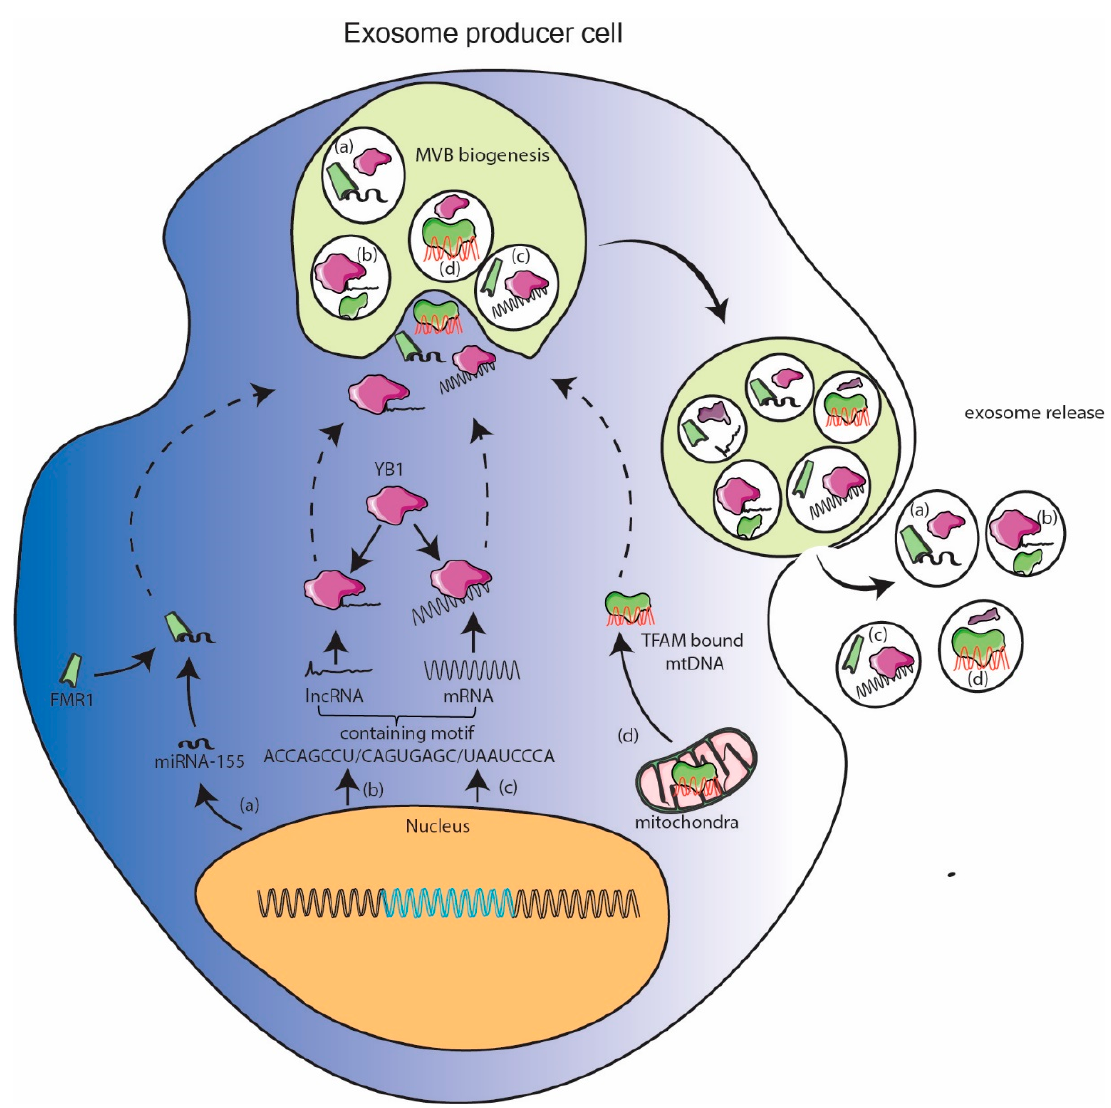
Figure 2. Cellular protein assisted packaging model. Cellular proteins which were found in exosomes can recruit nucleic acids with which they can interact by their inherent nature or with certain sequence. ( a ) enrichment of miR-155 with FMR1, ( b , c ) plausible enrichment of certain lncRNA and mRNA with YB1 and ( d ) enrichment of mtDNA with transcription factor of mitochondria (TFAM) are exemplified under this model.